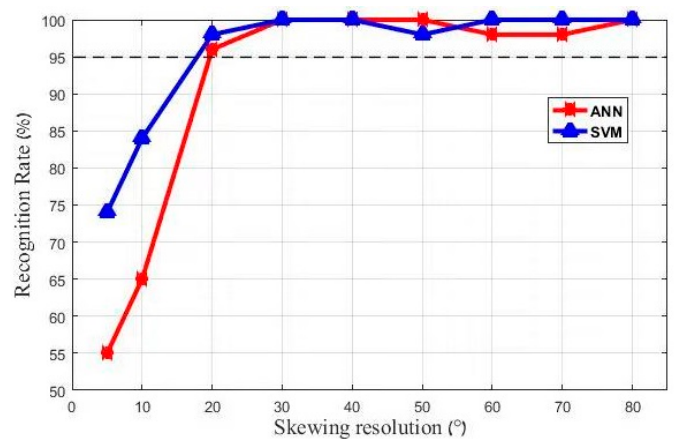
Figure 17. The recognition rate with different skewing resolution.